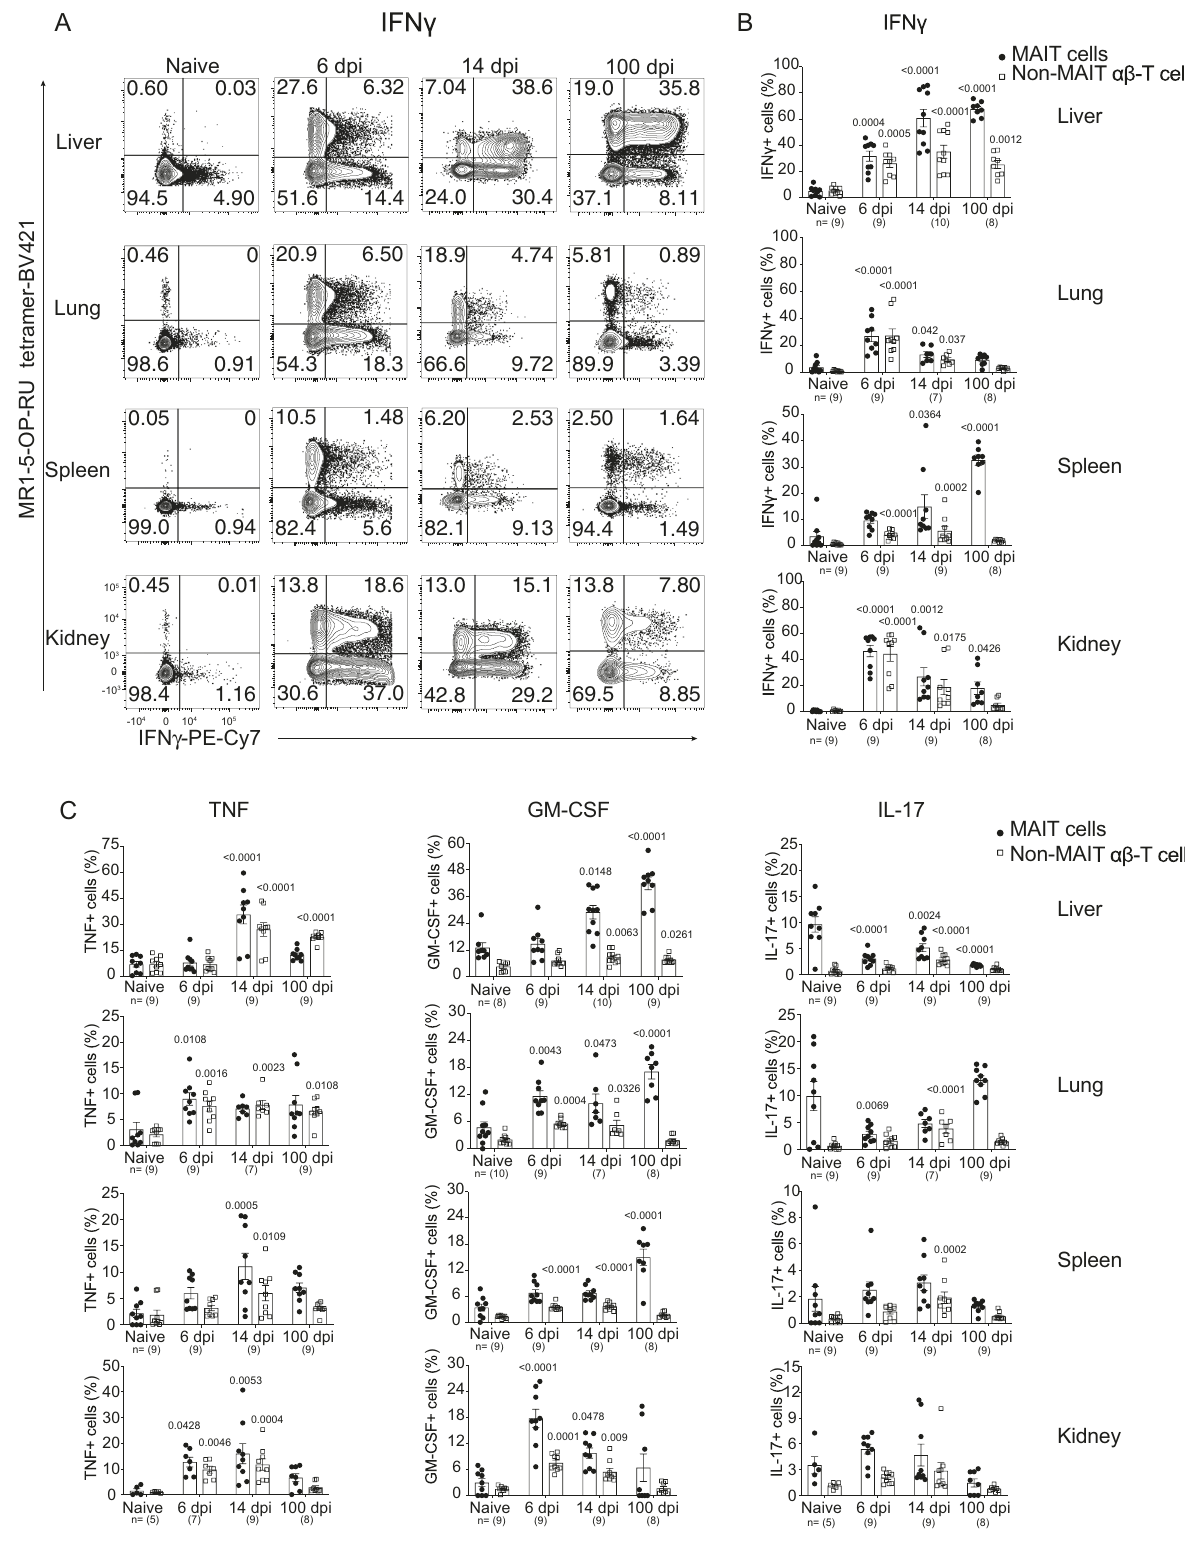
Fig. 3 Cytokine pro fi ling of MAIT cells upon F. tularensis LVS infection. A Representative fl ow cytometry plots showing intracellular cytokine staining for IFN γ of TCR β + lymphocytes from the liver, lungs, spleen, and kidneys of uninfected and infected mice on 6, 14, and 100 dpi with 2 × 10 4 CFU F. tularensis LVS i.v, after 4 h of culture with brefeldin A and PMA/ionomycin stimulation. B , C Percentages of B IFN γ and C TNF, GM-CSF, and IL-17-producing cells of gated MAIT cells and non-MAIT αβ -T cells from the liver, lungs, spleen, and kidneys from mice in A . Pooled data of two independent experiments with similar results (mean ± SEM, n = 5 – 10 mice per group, as indicated). Statistical tests: one-way ANOVA comparing percentages of cytokine-producing MAIT cells or non-MAIT αβ -T cells at indicated time points post infection with the matching uninfected groups. P -values < 0.05 are indicated. Source data are provided as a Source Data fi